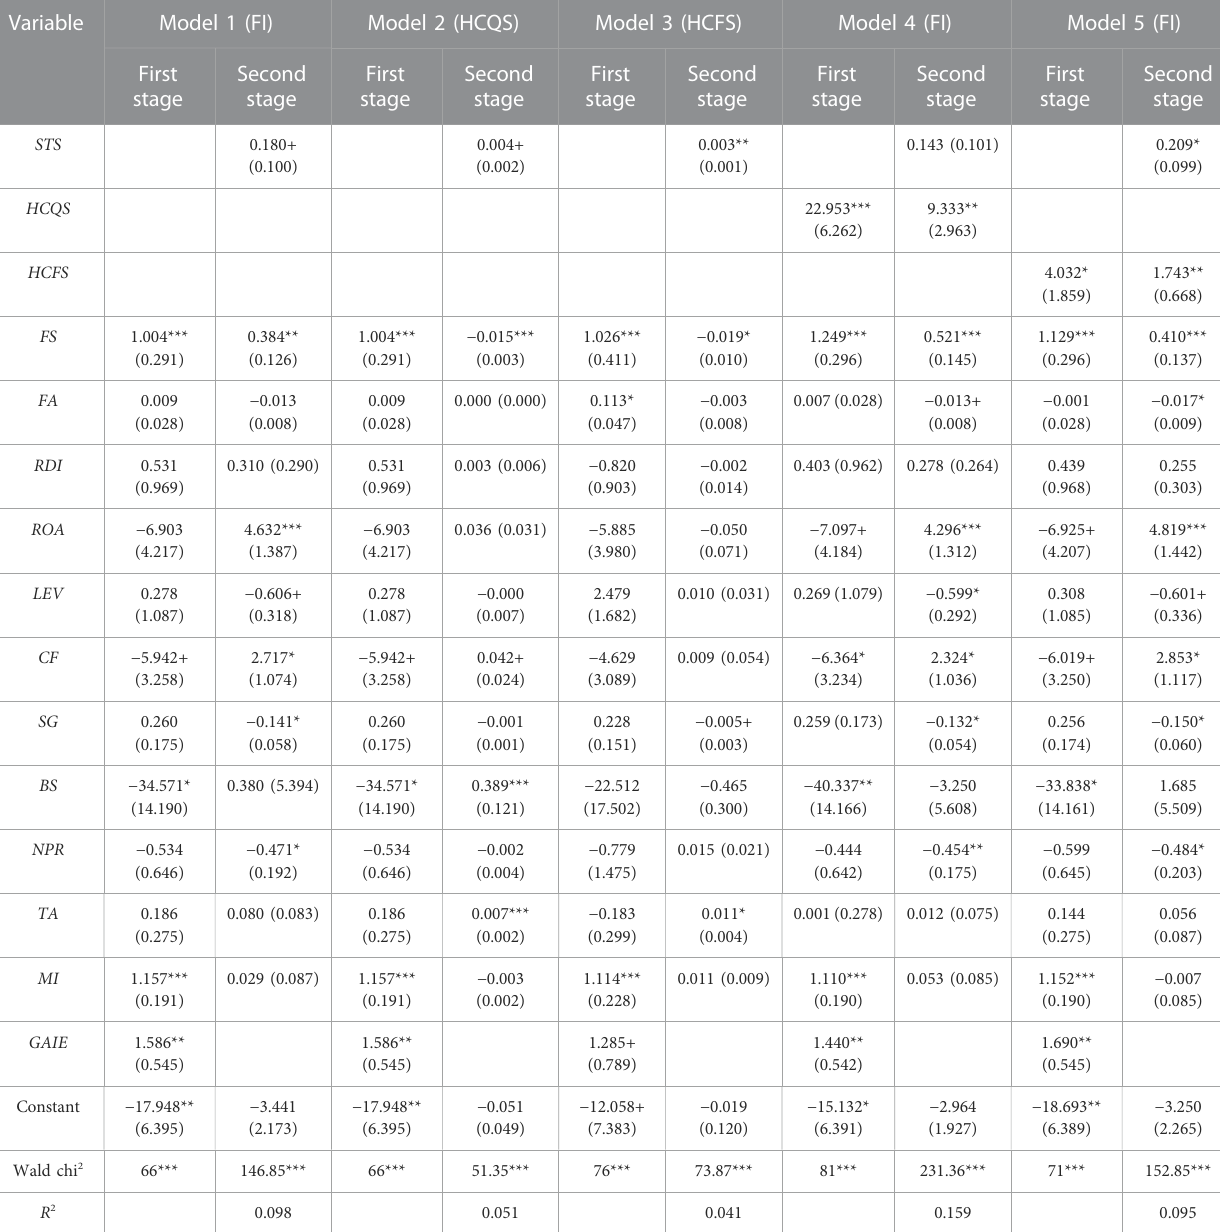
TABLE 14 Endogeneity test based on the instrumental